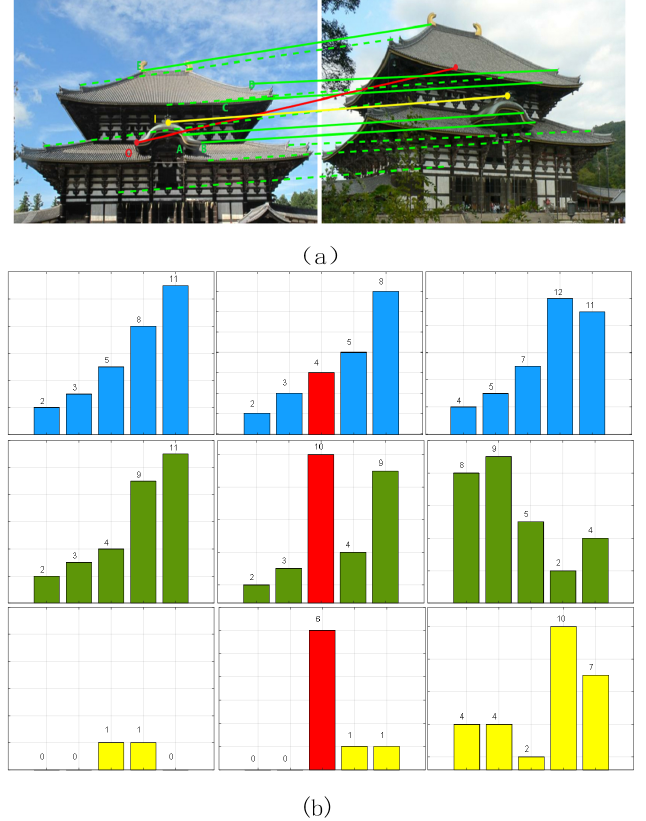
Figure 2. An example of the structure shift feature: ( a ) some correspondences on a pair of images; ( b ) from top to bottom: the distance rankings for the neighbors of a reference correspondence on the first image, the second image and their difference, respectively. From left to right: a correct reference correspondence (in yellow) with five correct neighbors (solid green lines), a correct reference correspondence (in yellow) with four correct neighbors (solid green lines) and a wrong neighbor point (solid red lines), a wrong reference correspondence (in red) with five correct neighbors (solid green